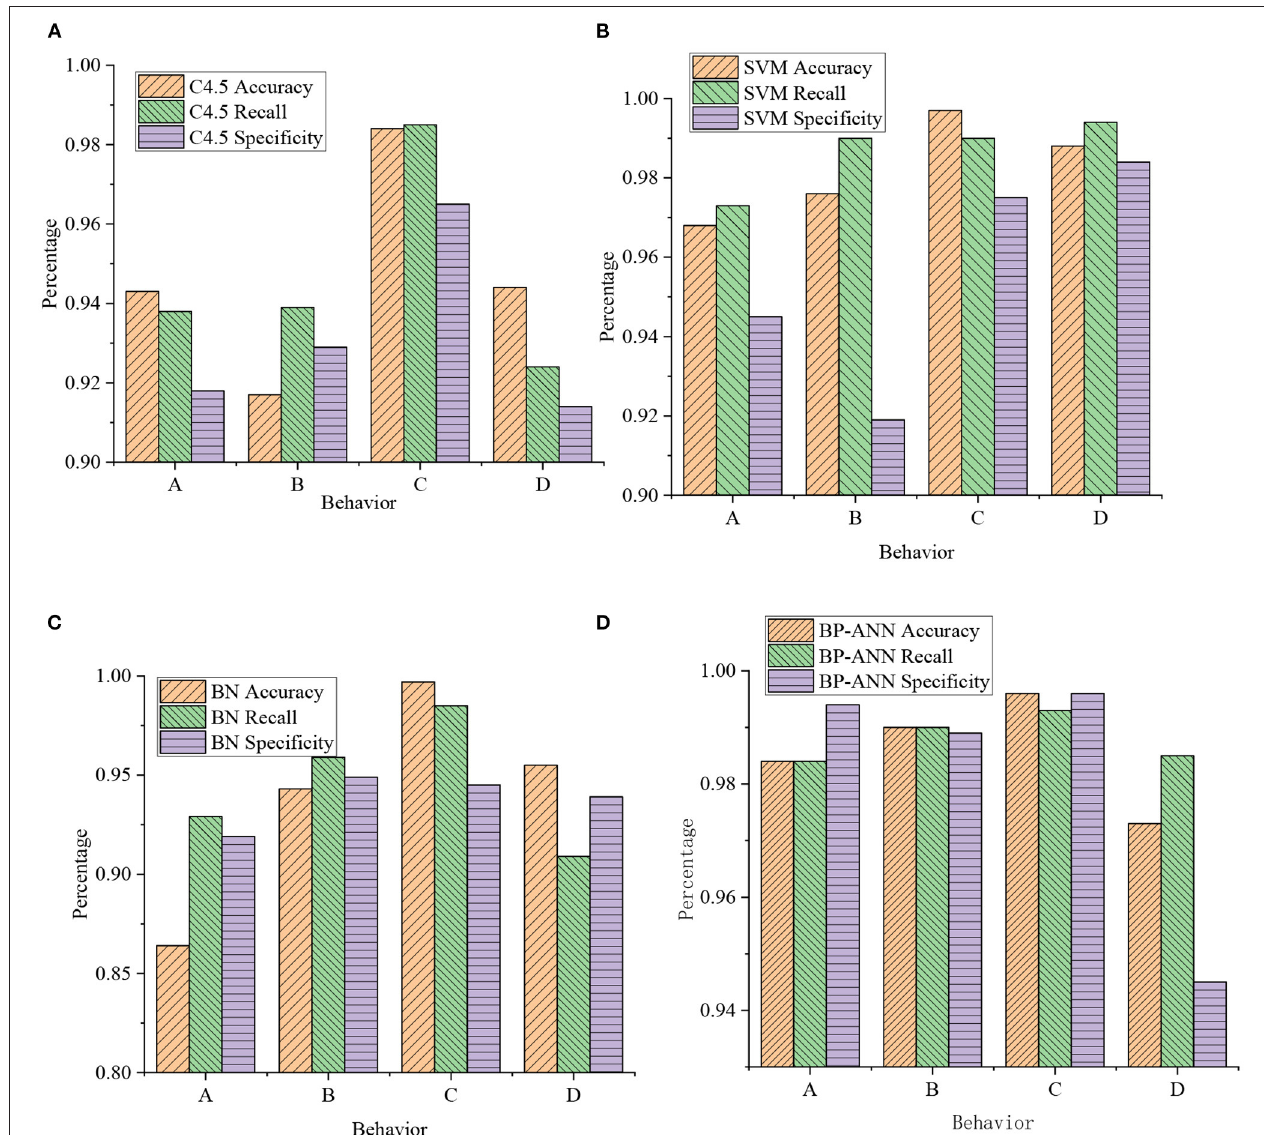
FIGURE 11 | Classification of upper limb movements by the four classification algorithms: (A) Accuracy and recall of C4.5; (B) accuracy and recall of SVM; (C) accuracy and recall of BN; and (D) accuracy and recall of BP-ANN (A: catching; B: passing; C: dribbling; D: shooting).